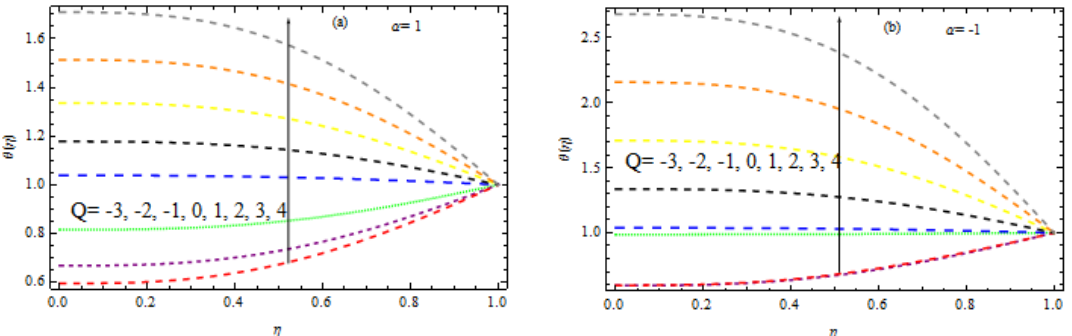
Figure 9. ( a , b ) Influence of heat source factor on temperature.